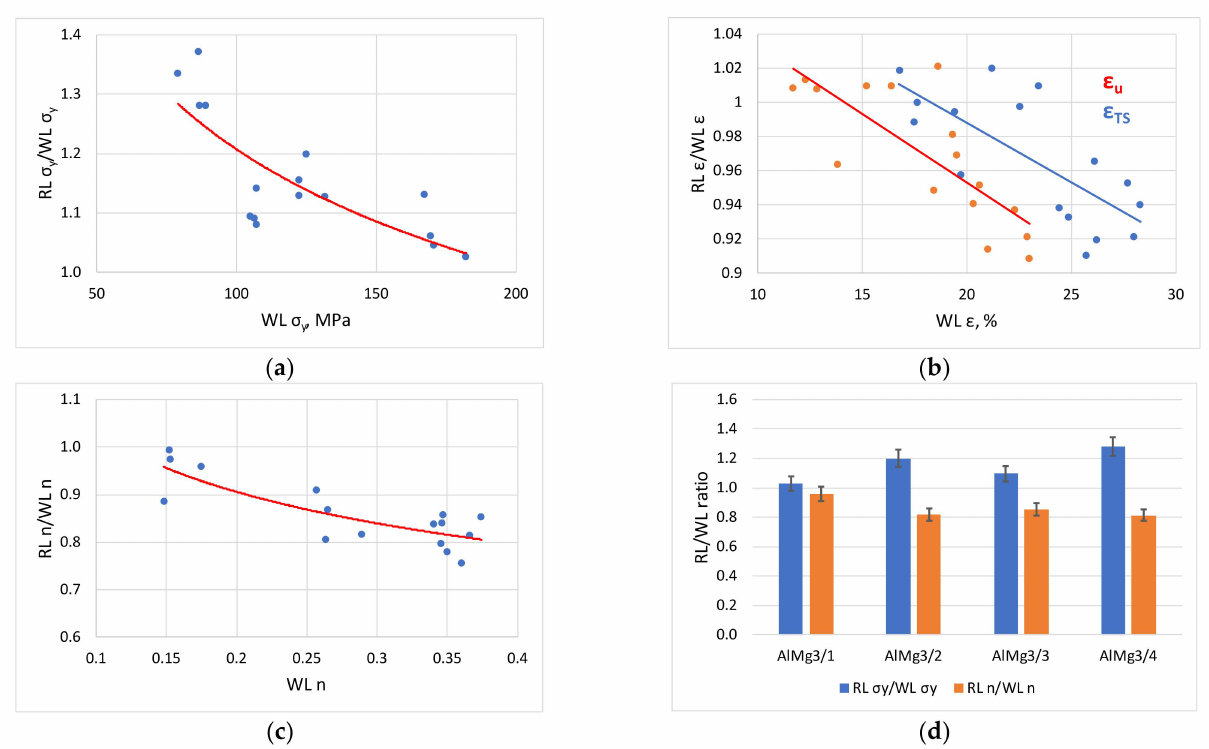
Figure 8. Relative change in tensile test parameters ( a – c ) the ratio of yield strength, elongation and hardening exponent for levelled and not levelled specimens; ( d ) yield strength and hardening exponent ratios for AlMg3.